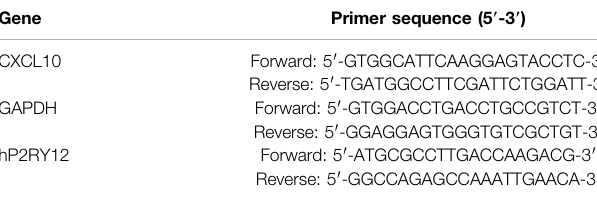
TABLE 2 | Primer sequences of RT-qPCR. Gene Primer sequence (5 9 -3 9